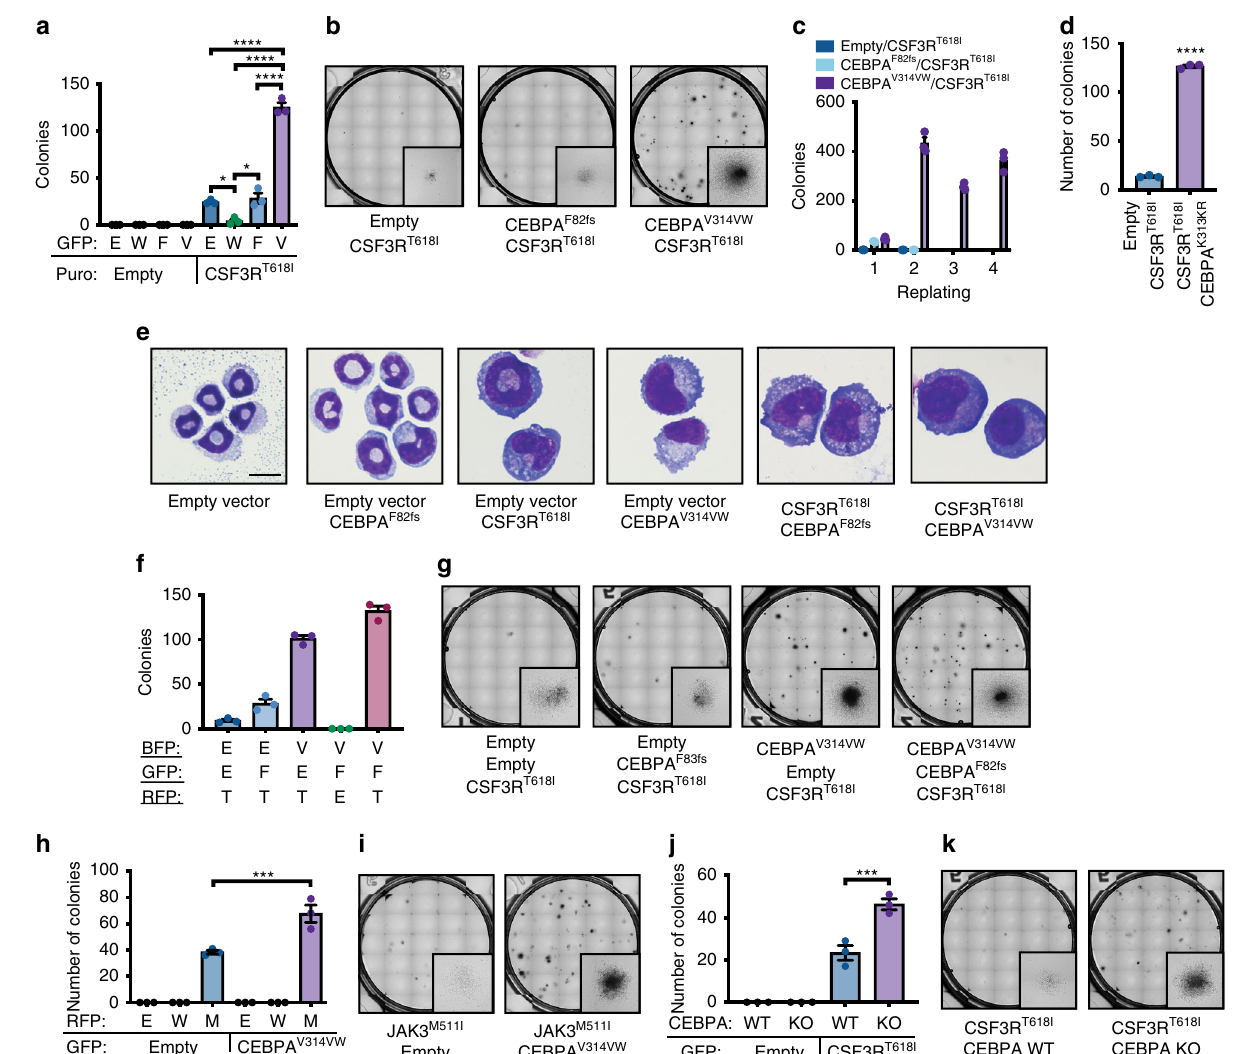
Fig. 1 CSF3R T618I and CEBPA mutations cooperate in vitro. a Colony assay from mouse bone marrow transduced with CSF3R T618I and either CEBPA WT (W), CEBPA F82fs (F), or CEBPA V314VW (V) ( n = 3/group). b Representative images for a . c Serial replating of colony assay in a . d Colony assay from mouse bone marrow transduced with CSF3R T618I and either empty vector or CEBPA K313KR . e Example images from cytospins of conditions in a grown for 72 h in cytokine-free liquid culture (scale bar represents 10 μ m). f Colony-forming assay from mouse bone marrow transduced with the combination of CSF3R T618I (T), CEBPA F82fs (F), CEBPA V314VW (V), two oncogene combinations and empty vector controls. In all, 1700 cells were plated per condition. g Representative images for f . h Colony assay from mouse bone marrow transduced with Empty Vector (E) JAK3 WT (W), JAK3 M511I (M), or CEBPA V314VW . i Representative images of colony assay for h . j Colony assay from mouse bone marrow from CEBPA KO or Cre- littermate control bone marrow transduced with Empty Vector or CSF3R T618I . k Representative colony assay images for j . In all cases n = 3/group and values are represented as mean with error bars representing SEM. Signi fi cance of comparisons assessed by ANOVA with Sidak post-test * p < 0.05, *** p = 0.001, **** p < 0.0001). Source data are provided as a Source Data fi